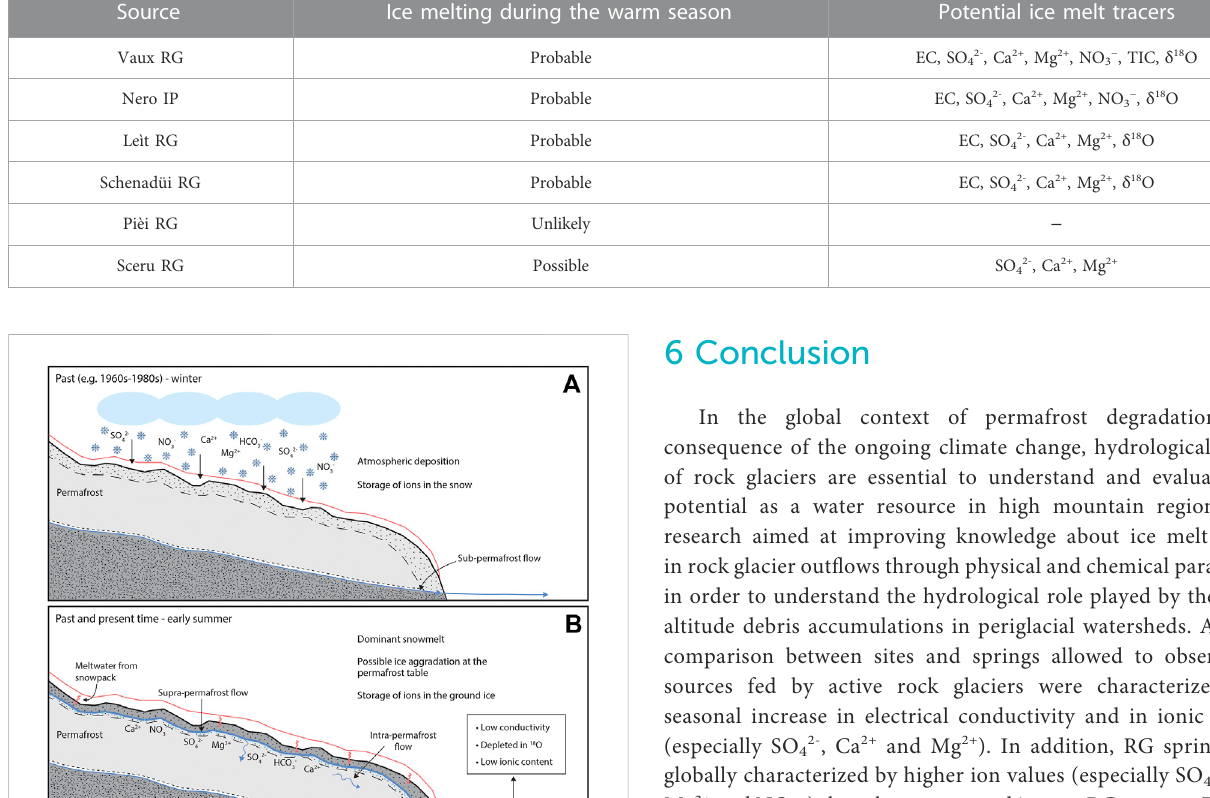
TABLE 6 Summary of the potential ice melt tracers resulting from the spatial comparison between sources and sites. Source